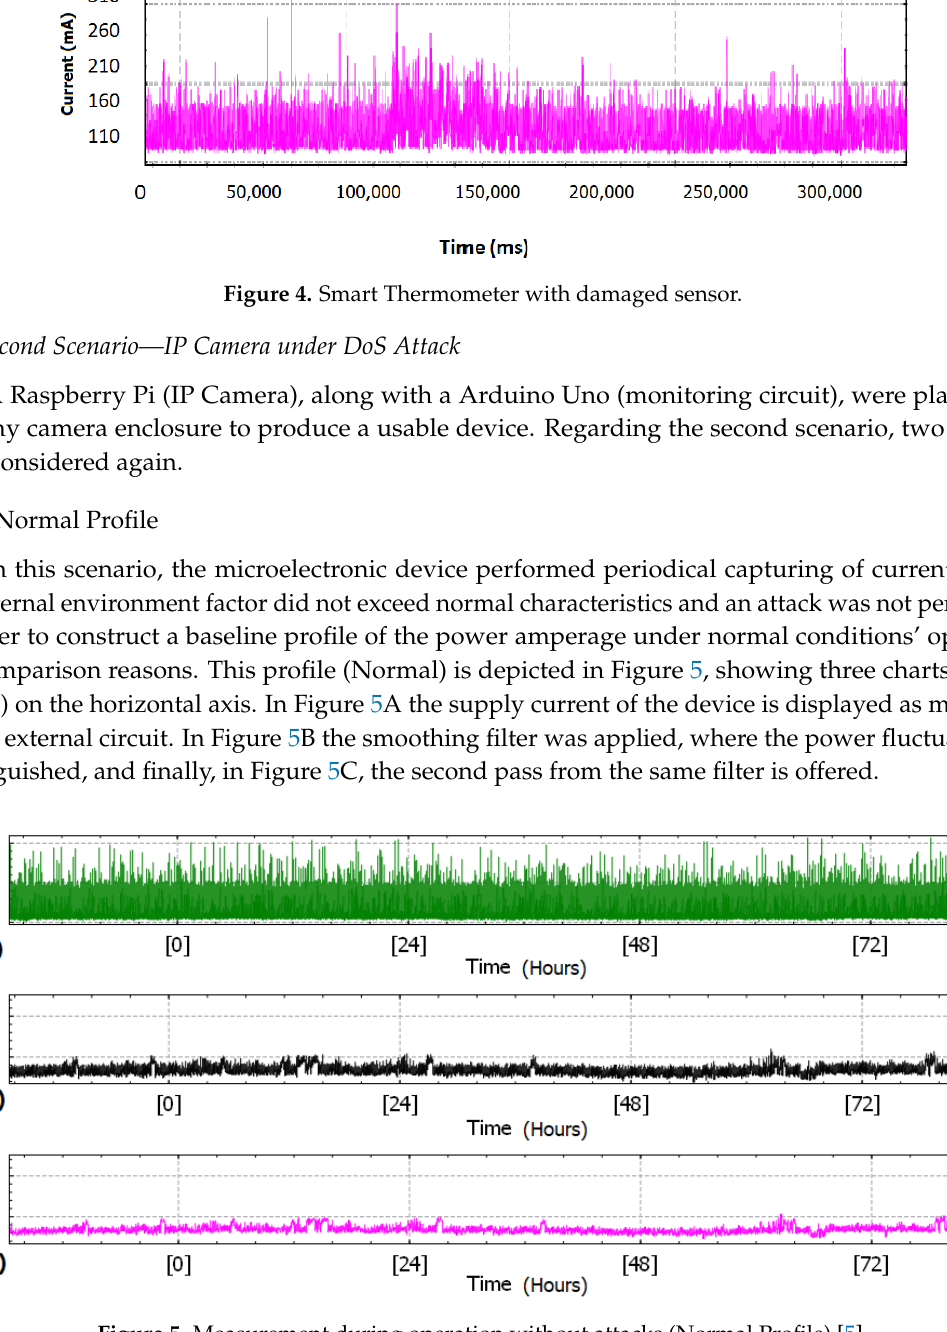
Figure 5. Measurement during operation without attacks (Normal Profile)